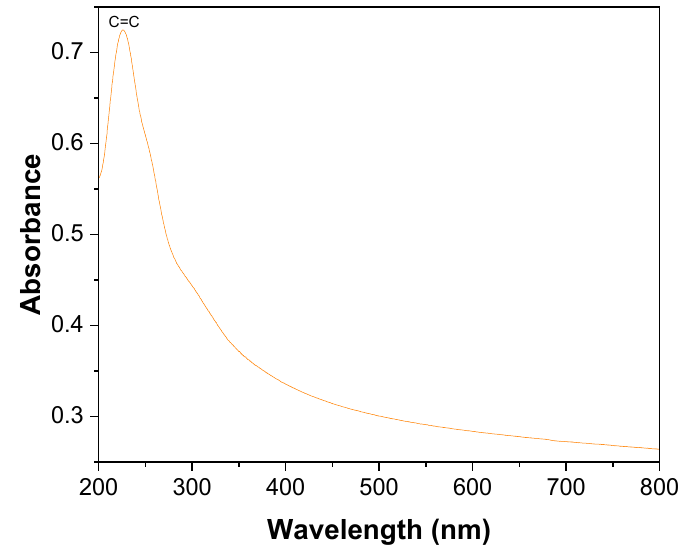
Figure 5. UV-vis absorption spectrum of CNTs-Ag 2 Figure 5. UV ‐ vis absorption spectrum of CNTs ‐ Ag 2 S. Figure 5. UV ‐ vis absorption spectrum of CNTs ‐ Ag 2 S.